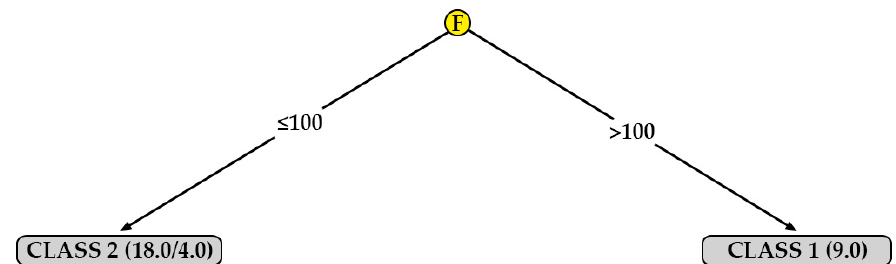
Figure 8. Decision tree for surface roughness measured in the direction perpendicular to the extrusion path on printed specimens in the XY orientation (R a,90,XY ).